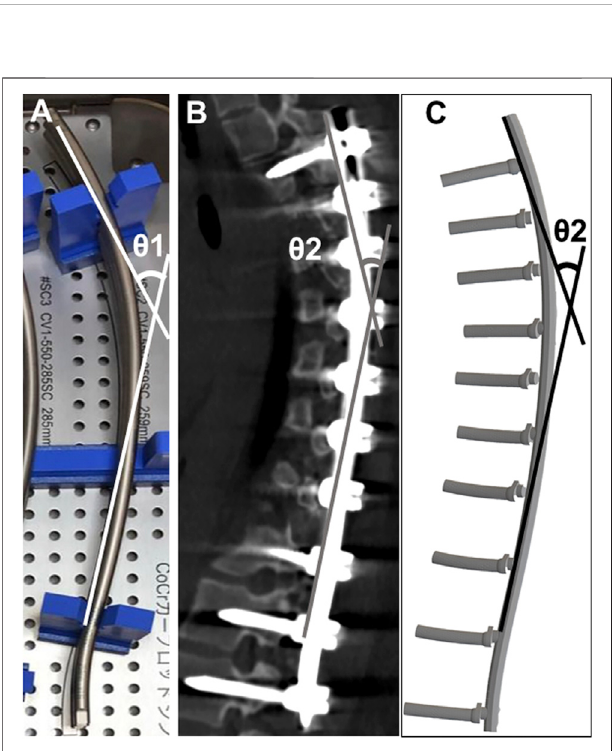
FIGURE 2 | Rod angle before and after implantation (A) Prior to implantation, the angle between the proximal and distal tangential line was measured ( θ 1). Postoperative implant rod geometry ( θ 2) was obtained after the surgery using computed tomography (B) and the simulation model (C)